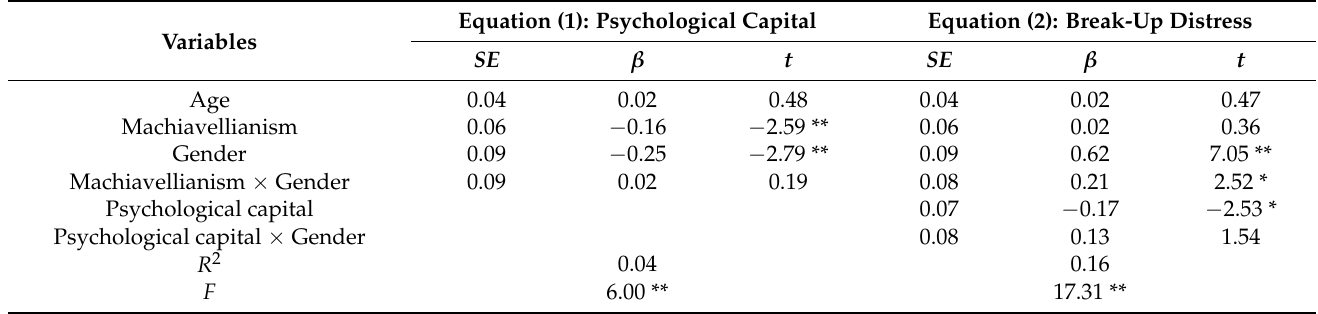
Table 2. Moderated mediating effect analyses.